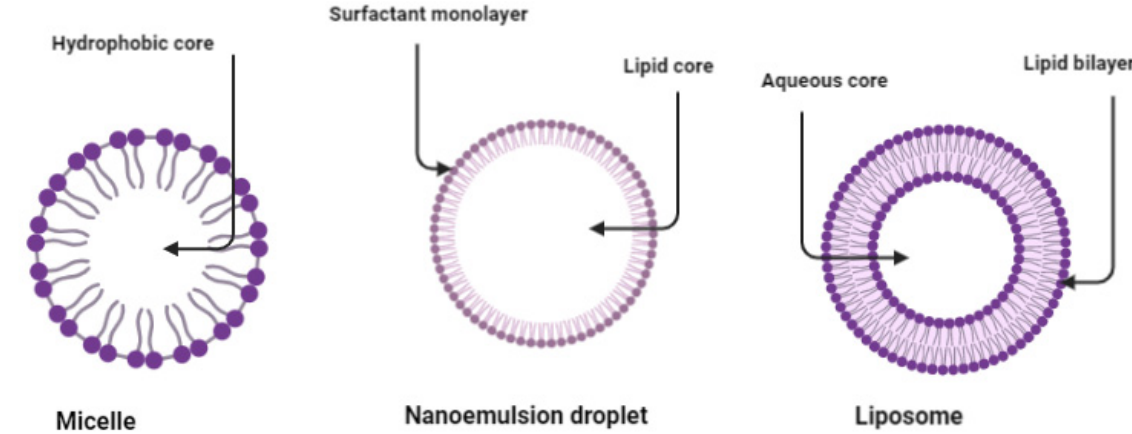
Figure 5. Structural form and composition of the micelle, nanoemulsion droplet and liposome formulations. The tail of the surfactant forms the hydrophobic core of the micelle. Nanoemulsion water-in-oil stabilized by surfactant surround lipid core. Liposome lipid bilayer and aqueous core.